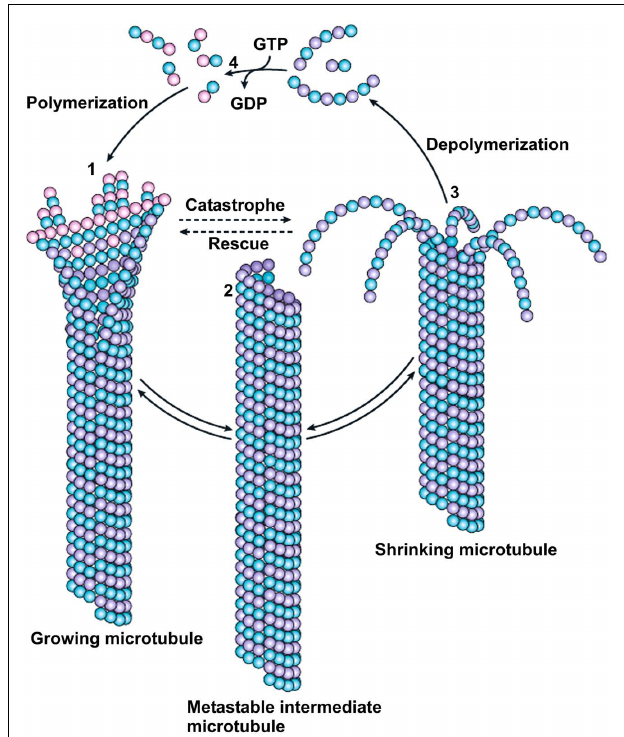
FIGURE 3 | Dynamic instability of microtubules. Polymerization of microtubules is initiated from a pool of GTP-loaded tubulin subunits (pink beads). GTP hydrolysis changes the conformation of the protofilament from a slightly curved tubulin-GTP to a more sharply curved tubulin-GDP structure.The curved tubulin-GDP (lilac beads) is forced to remain straight when it is part of the microtubule wall. Growing